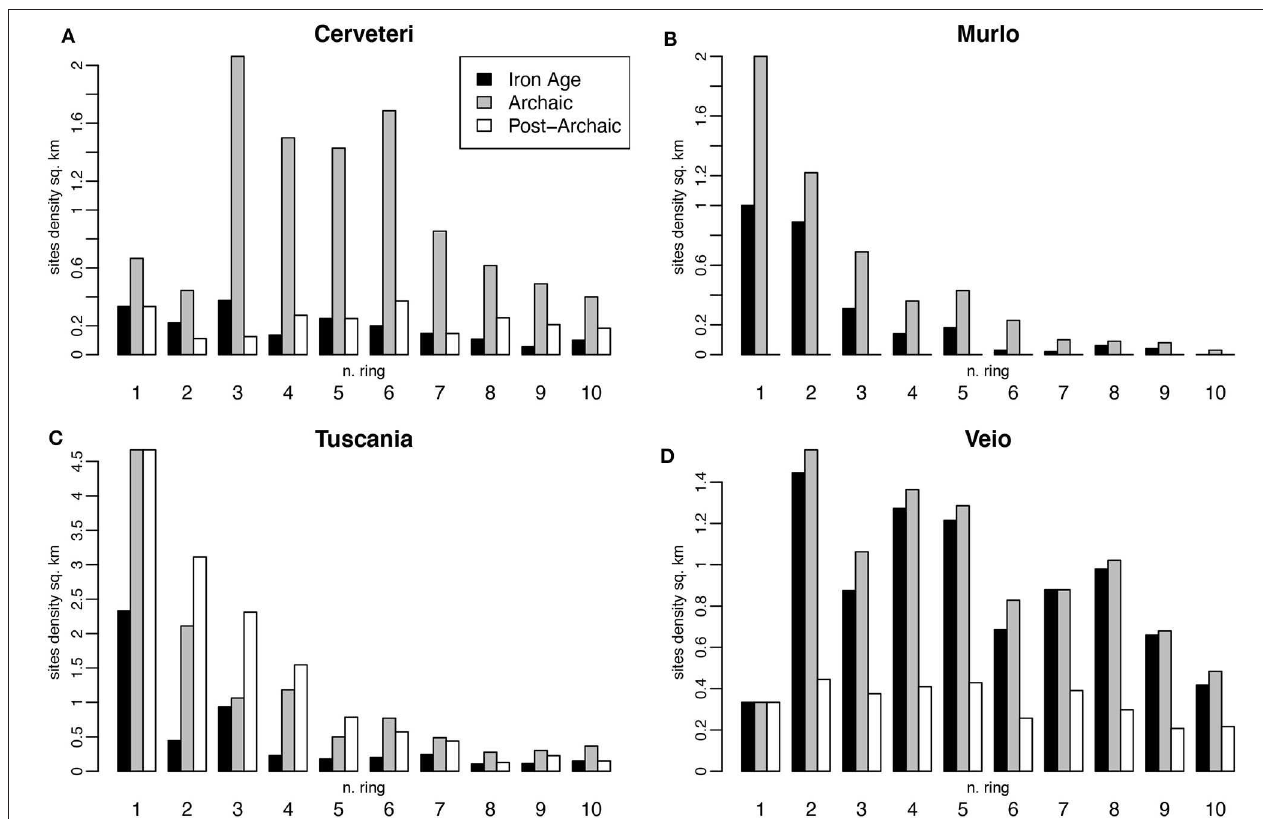
FIGURE 14 | Sites density at increasing distance (concentric rings) from Cerveteri (A) , Murlo (B) , Tuscania (C) , and Veio (D) . Murlo was not occupied in the Post-Archaic